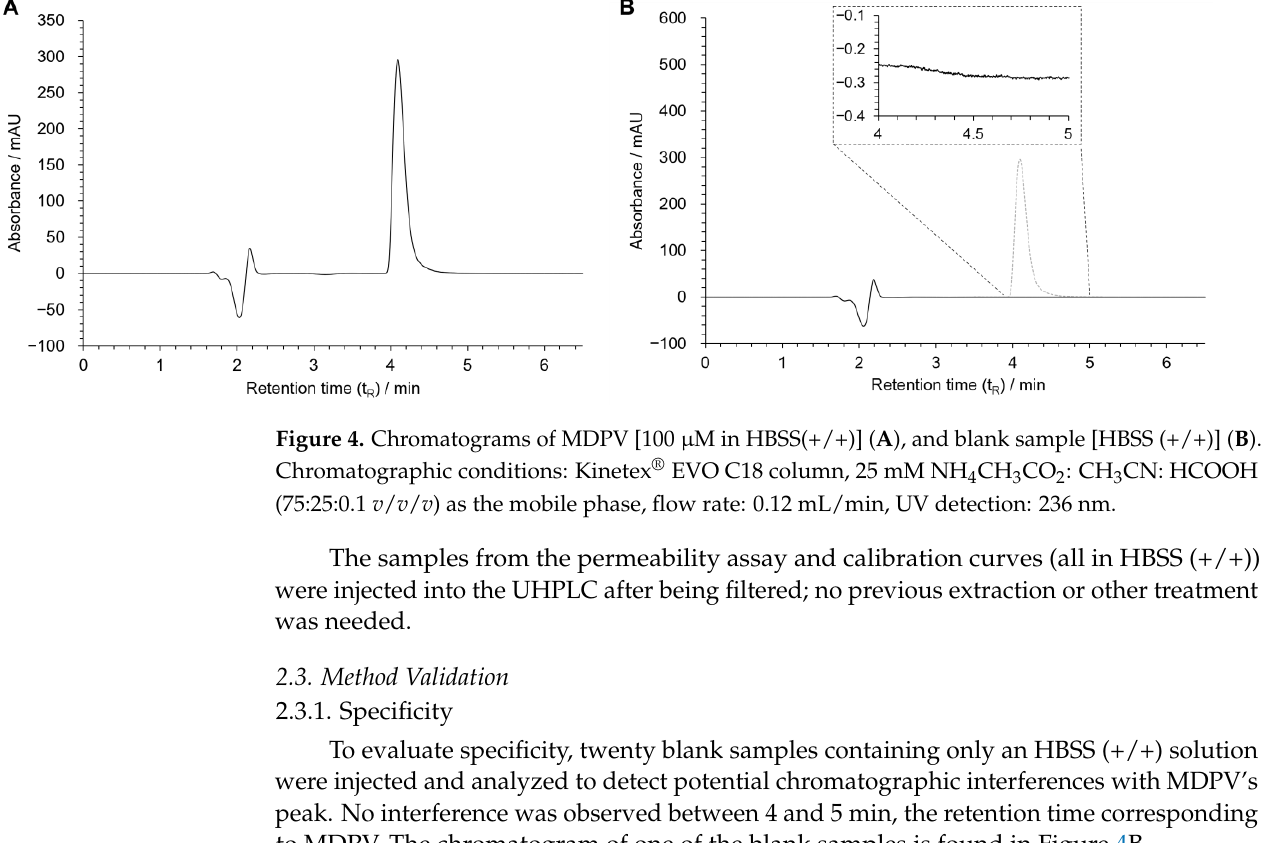
Figure 3. UV spectra of MDPV [ 100 µM in HBSS (+/+)], mobile phase [25 mM NH₄CH₃CO₂: CH₃CN: HCOOH (75:25:0.1 v / v / v )] and HBSS(+/+).